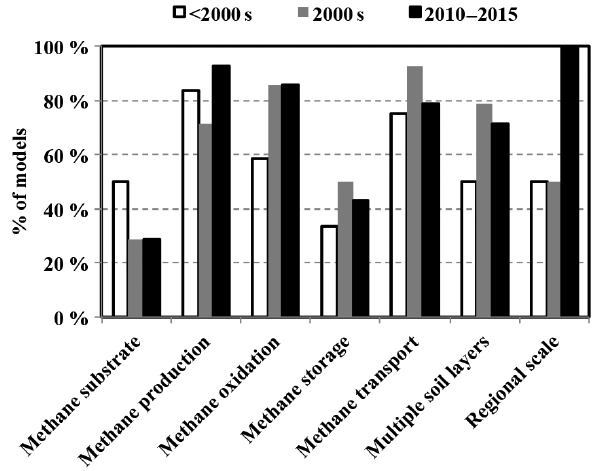
Figure 2. Percentage of CH 4 models with consideration of some key CH 4 mechanisms. The percentage was calculated as the number of models considering each mechanism divided by the total number of published models in each time period.